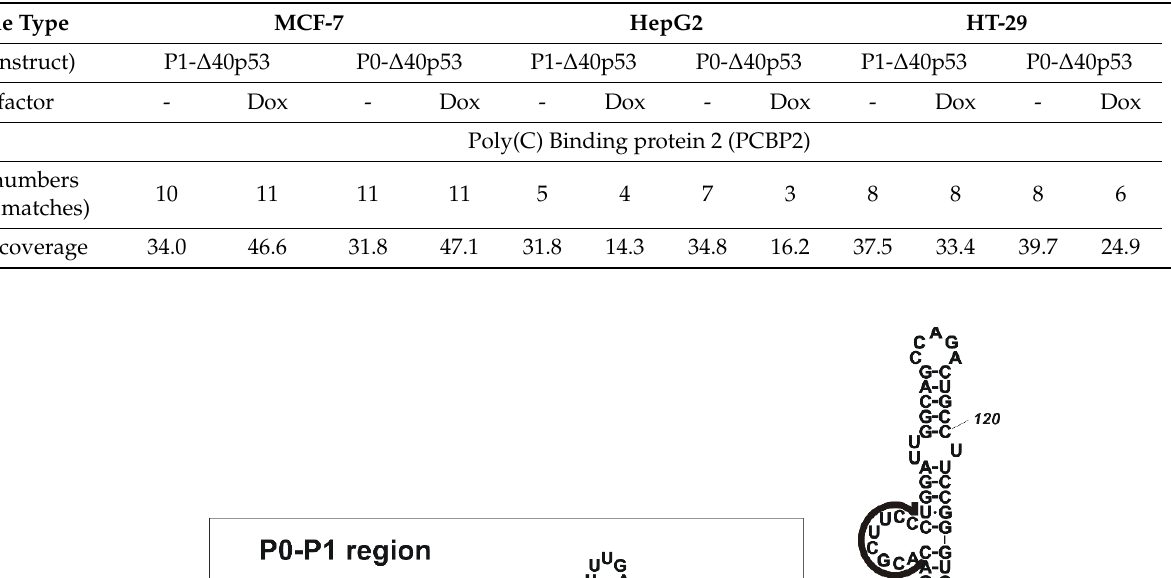
Table 1. MS data for poly(C)-binding protein 2 from representative RNA-centric affinity chromatography experiments for cell lines MCF-7, HepG2 and HT-29 and each of the tested conditions [6]. The table shows the numbers of sequence matches and sequence coverage [%] for PCBP2 in a particular experiment. Dox—doxorubicin treatment generating stress conditions.